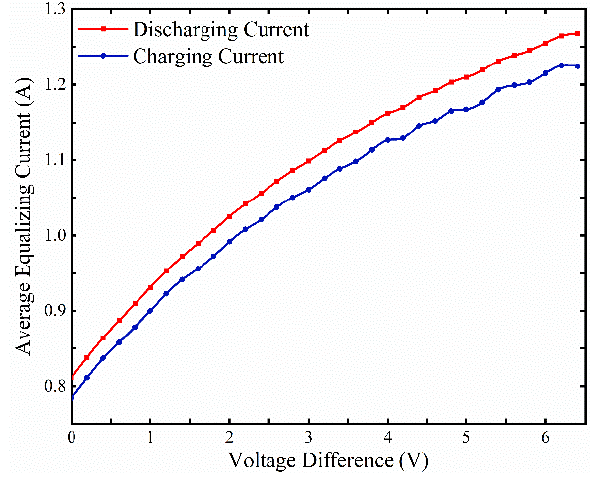
Figure 13. Variation of average equalizing current with voltage difference.